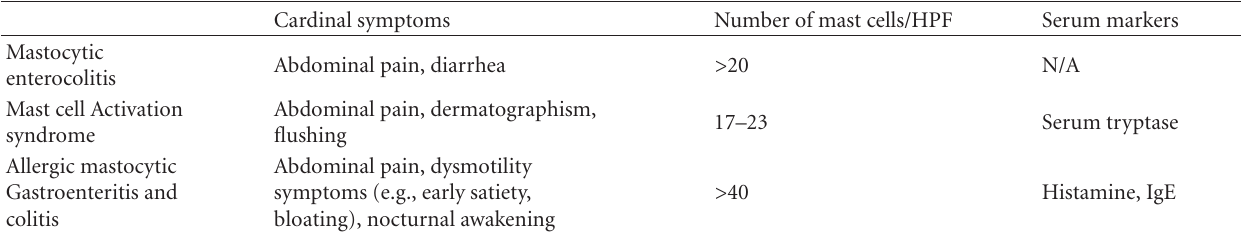
Table 6: Comparison between di ff erent GI mast cell diseases [20,